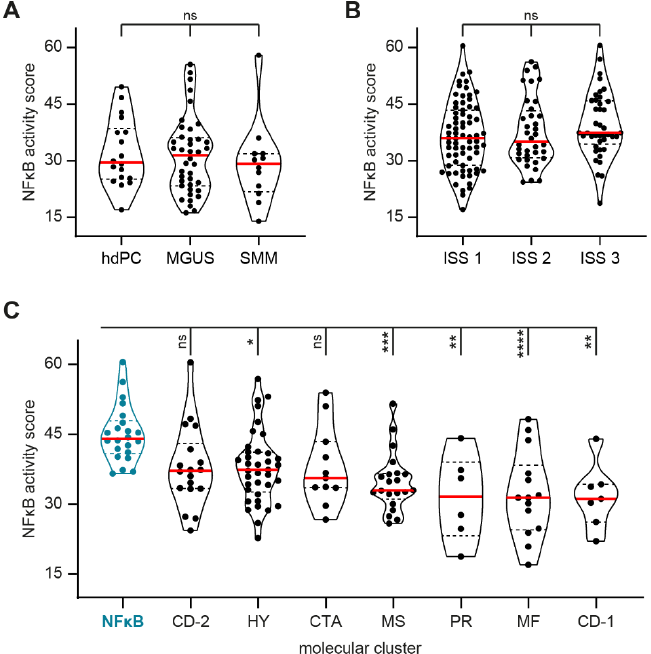
Figure 1. Violin plots showing NF κ B activity score as analyzed by signal transduction pathway activity (STA) analysis in plasma cells (PC) from ( A ) healthy donors (hdPC), pre-malignant monoclonal gammopathy of undetermined significance (MGUS) patients, and asymptomatic smoldering multiple myeloma (SMM) patients, as incorporated in dataset GSE5900; ( B ) newly diagnosed MM patients, stratified by the international staging system (ISS) into good-prognosis ISS 1, intermediate-prognosis ISS 2, and poor-prognosis ISS 3, as incorporated in dataset GSE19784; ( C ) newly diagnosed MM patients, stratified by molecular clusters, as incorporated in dataset GSE19784. Included samples are represented by individual data points, solid red lines indicate the median, and dashed lines indicate the quartiles of the population. ns, not significant, * p < 0.05, ** p < 0.01, *** p < 0.001, **** p < 0.0001.